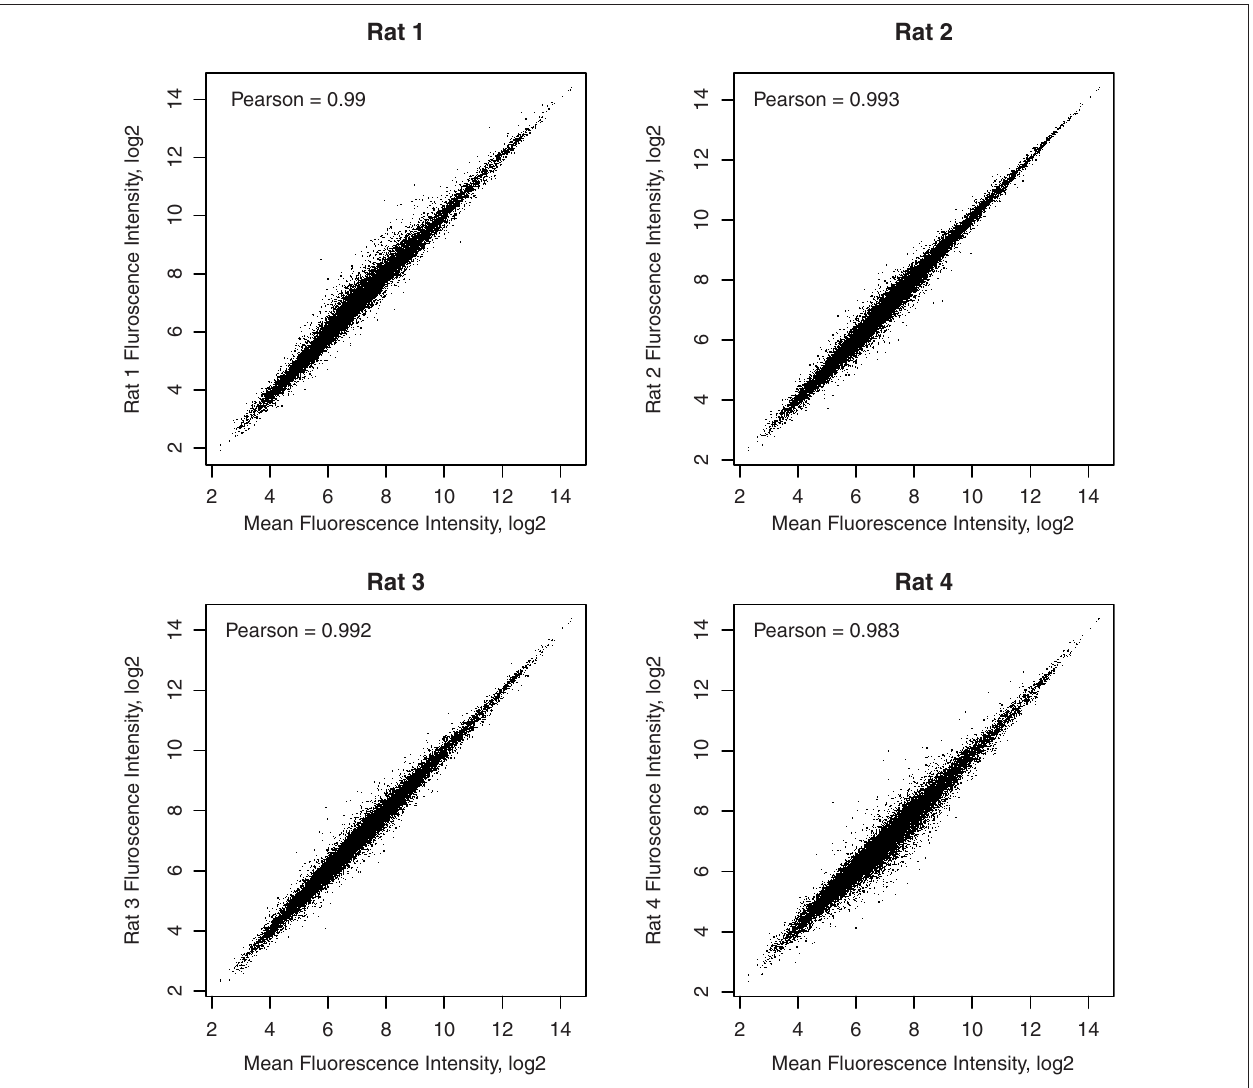
FiGuRe 2 | Correlation of each microarray sample with the mean of all samples. The correlation coefficients between the gene expression levels in each rat and the mean expression levels of the four rats are reported in the respective graphs. The high correlations demonstrated the reliability of detection of microarays.